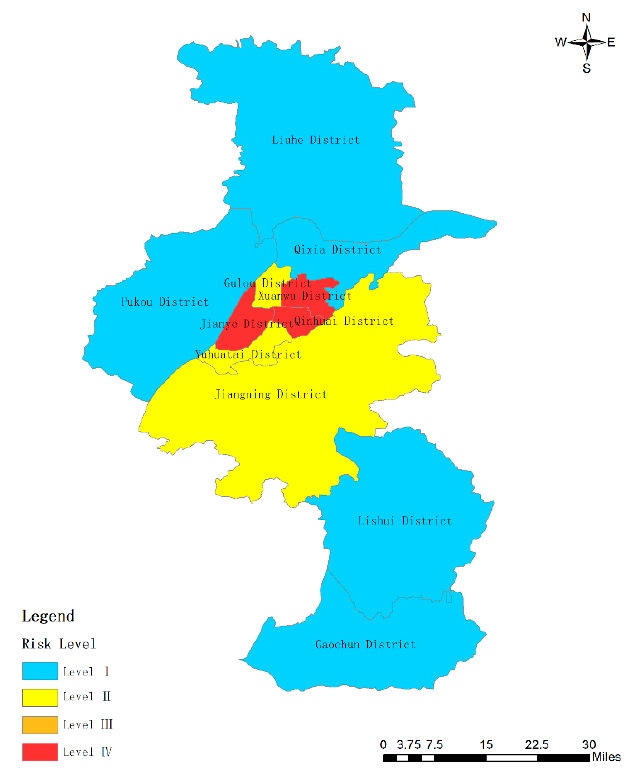
Figure 6. Risk level of subsystem Y 2 in Nanjing.